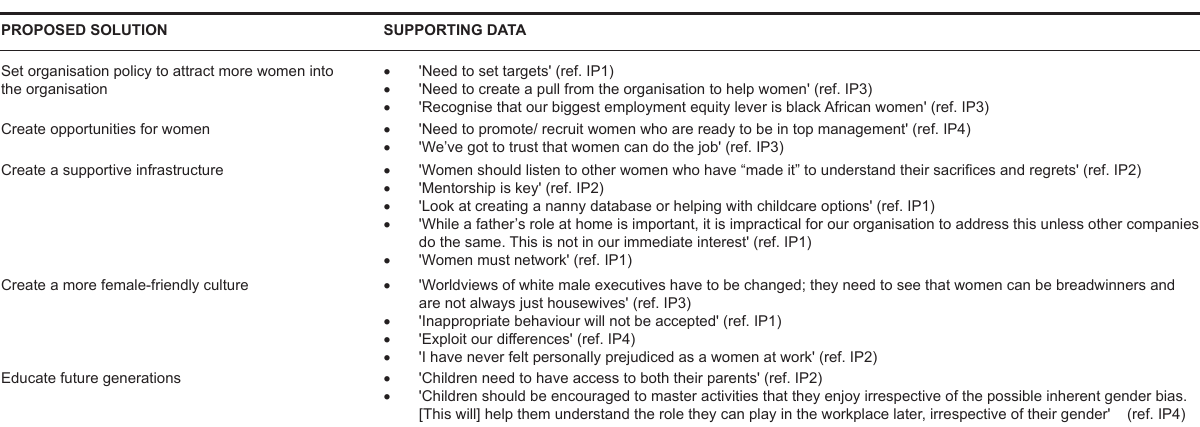
TABLE 10 Solutions proposed by